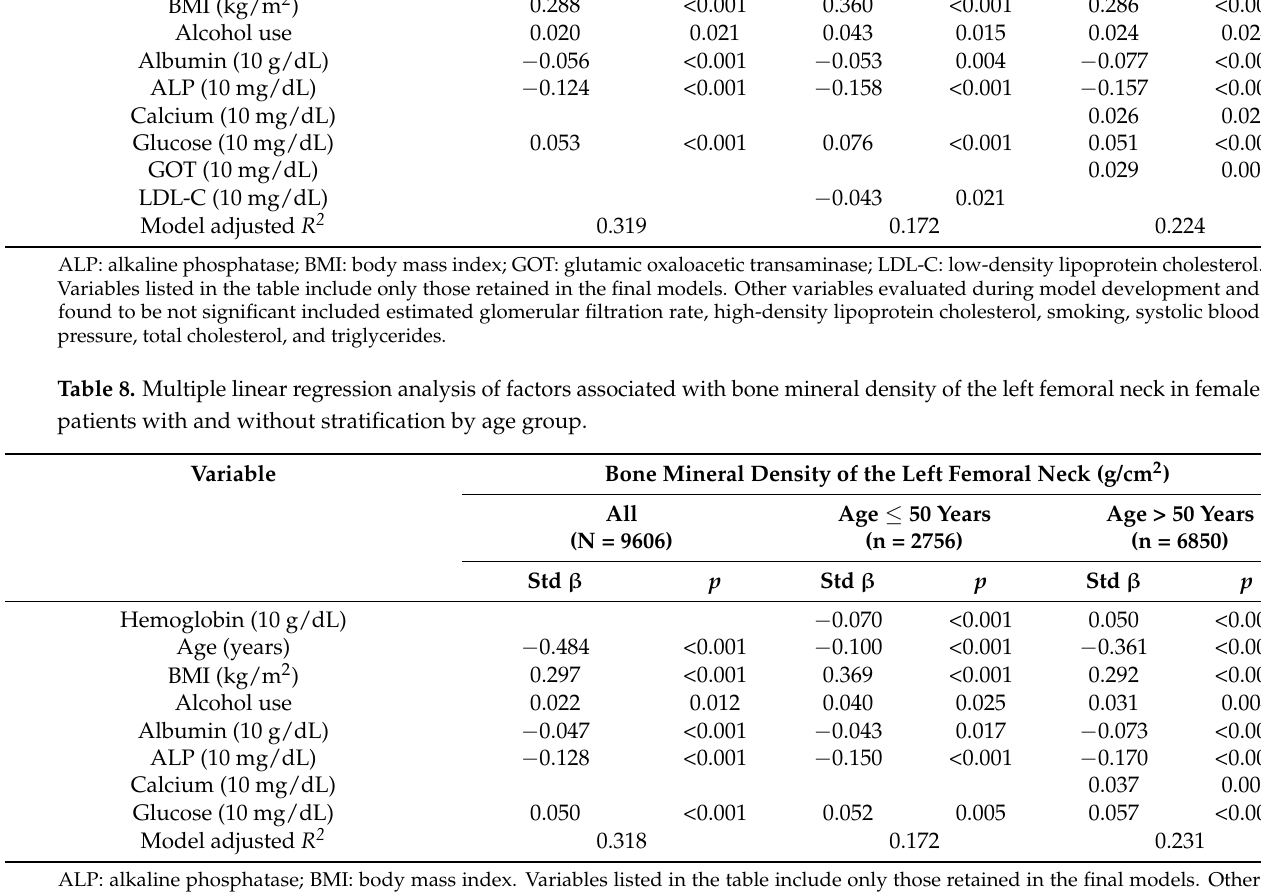
ALP: alkaline phosphatase; BMI: body mass index. Variables listed in the table include only those retained in the final models. Other variables evaluated during model development and found not significant included estimated glomerular filtration rate, glutamic